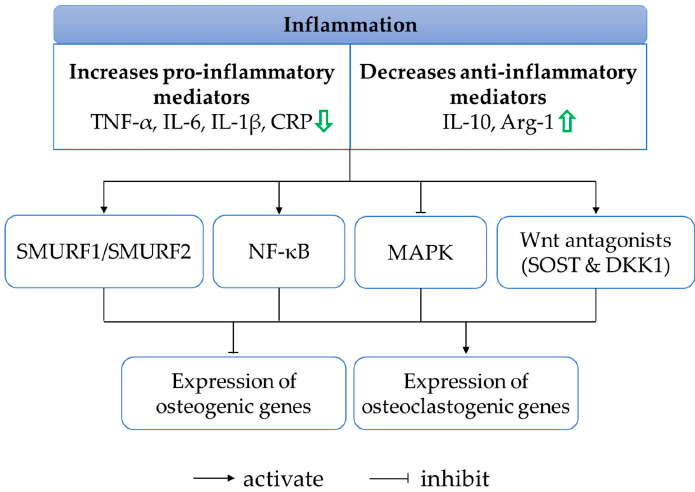
Figure 5. The e ff ects of quercetin on the regulation of inflammatory response in protecting bone. An overwhelming inflammation triggers the activation of SMURF1 / SMURF2, NF- κ B, inhibition of MAPK and increases production of Wnt antagonists, leading to enhancement of osteogenic genes and suppression of osteoclastogenic genes. Quercetin attenuates the inflammatory response by reducing pro-inflammatory mediators and increasing anti-inflammatory mediators (indicated by the green arrows). Abbreviations: Arg-1 = arginase-1; CRP = C-reactive protein; DKK-1 = Dickkopf-related protein 1; IL-1 β = interleukin-1 beta; IL-6 = interleukin-6; IL-10 = interleukin-10; MAPK = mitogen-activated protein kinase; NF- κ B = nuclear factor-kappa B; SMURF = suppressor of mothers against decapentaplegic ubiquitylation regulatory factor 1; SOST = sclerostin; TNF- α = ; tumour necrosis factor-alpha.